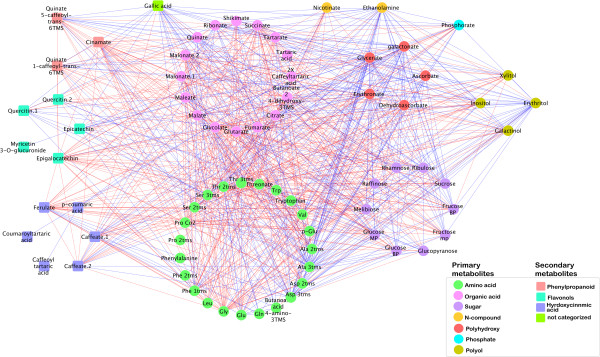
Changes in Cabernet Sauvignon metabolite interactions as a result of water deficit. Nodes correspond to primary (circles) and secondary (squares) metabolites; node colors correspond to compound classes as detailed in the figure legend. Edges between nodes represent correlations identified as significant at r ≥ 0.9 and q ≤ 0.01, where blue edges correspond to the irrigated treatment and red edges correspond to the water deficit treatment. Nodes are ordered into modules corresponding to their compound classes.